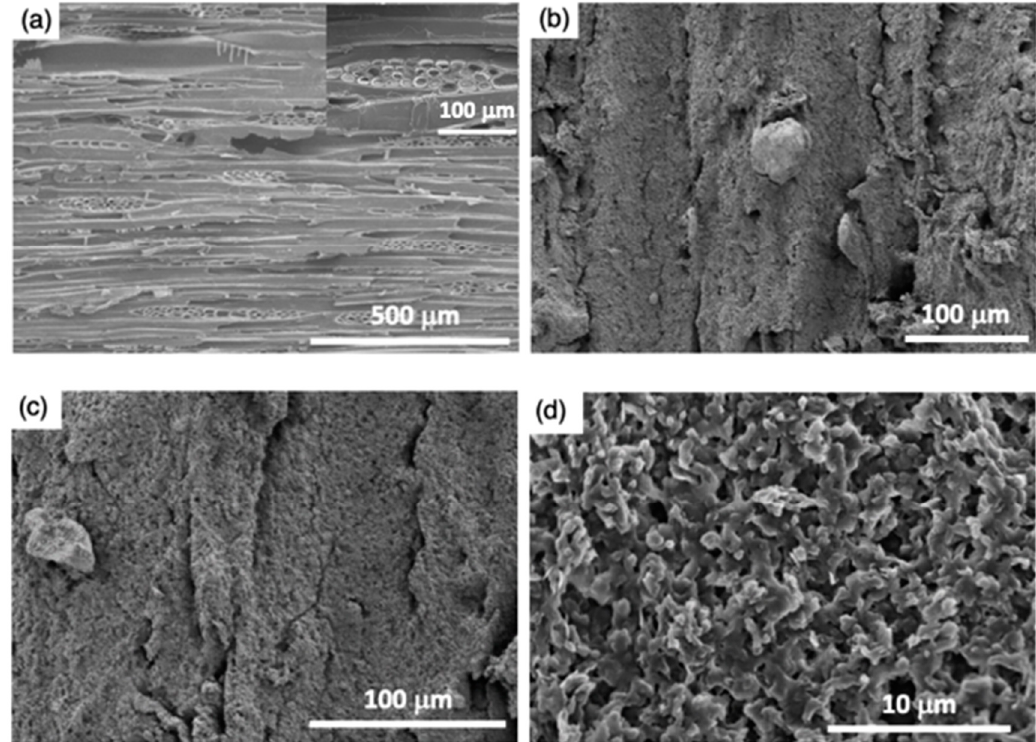
Figure 3. Field emission scanning electron microscopy (FESEM) images of the surfaces of ( a ) uncoated